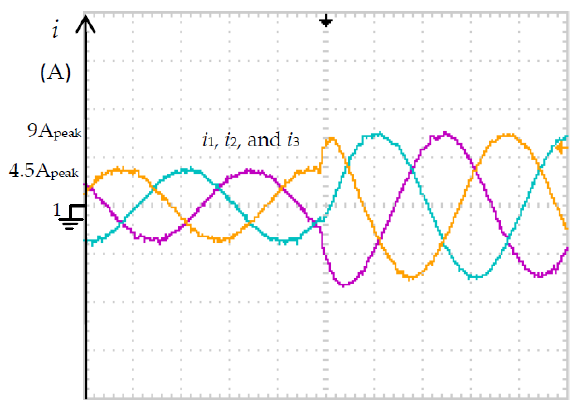
Figure 9. Experimental results of AC currents, i 1 , i 2 , and i 3 , of AC microgrid when there is a variation of AC power in step. Vertical: 6 A/div. Horizontal: 5 ms/div.